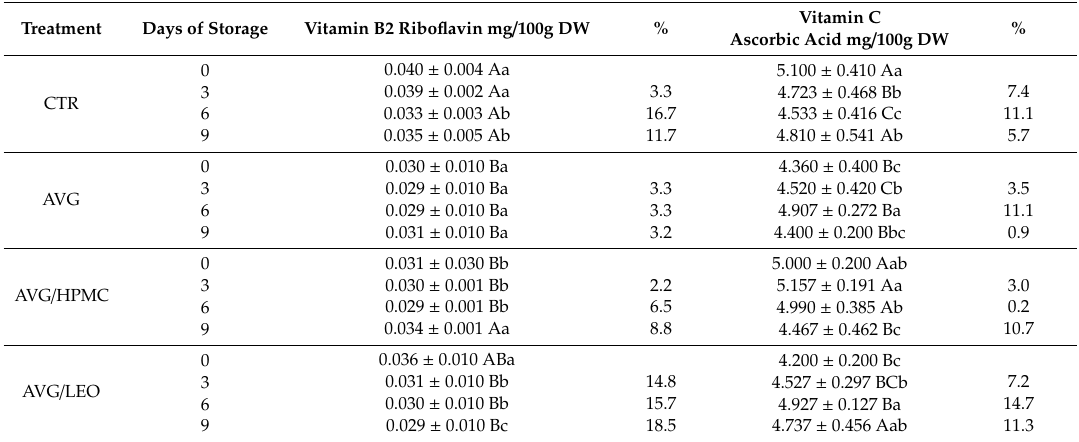
Table 5. Vitamin content of fresh-cut apples at 0, 3, 6, and 9 days of storage at 4 ◦ ± 1 ◦ C and 90% ± 5% RH after all